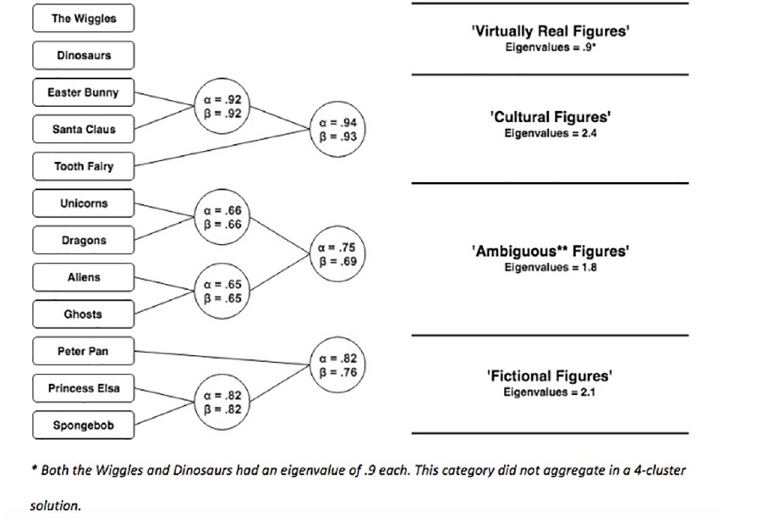
Fig 6. Cluster analysis with a 5 cluster solution.